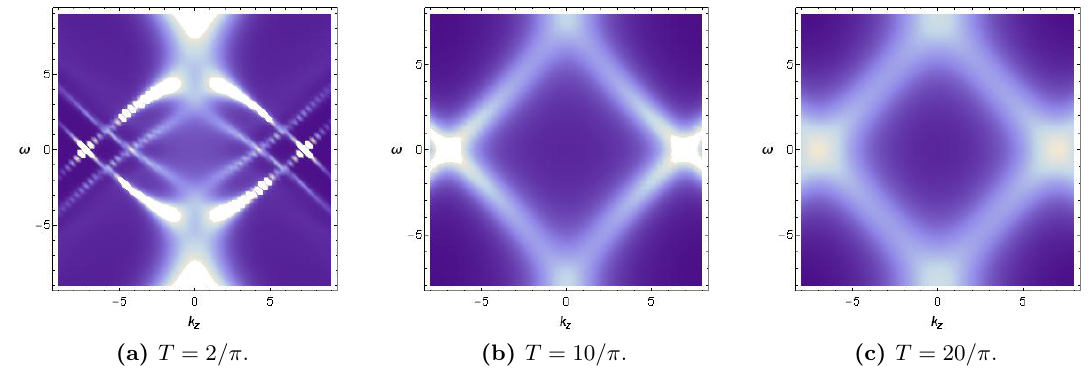
Figure 10. (a)-(c): temperature e(cid:11)ect on the spectral function when ( b; M ) = (8 ; 5 : 5) on ( k z ; ! )- space with k x = k y =